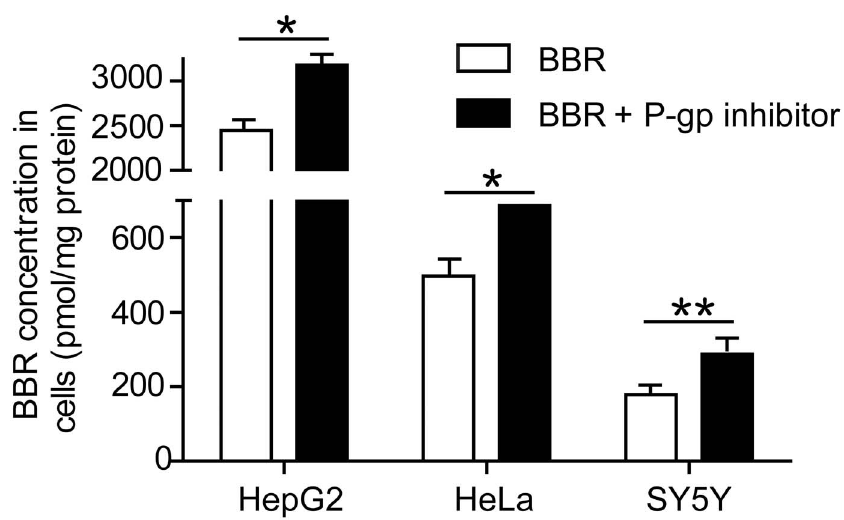
Figure 4. Effect of P-glycoprotein (P-gp) inhibitor on BBR uptake in HepG2, HeLa and SY5Y cells. Cells were treated with 0.5 m g/ml BBR and 0.3 m mol Zosuquidar, the inhibitor of P-gp activity, for 12 h. The intracellular concentrations of BBR were determined by HPLC assay. Data are presented as mean 6 S.D from three independent experiments (n=3). * v.s. the control, P , 0.05. ** v.s. the control, P , 0.005, t -test.